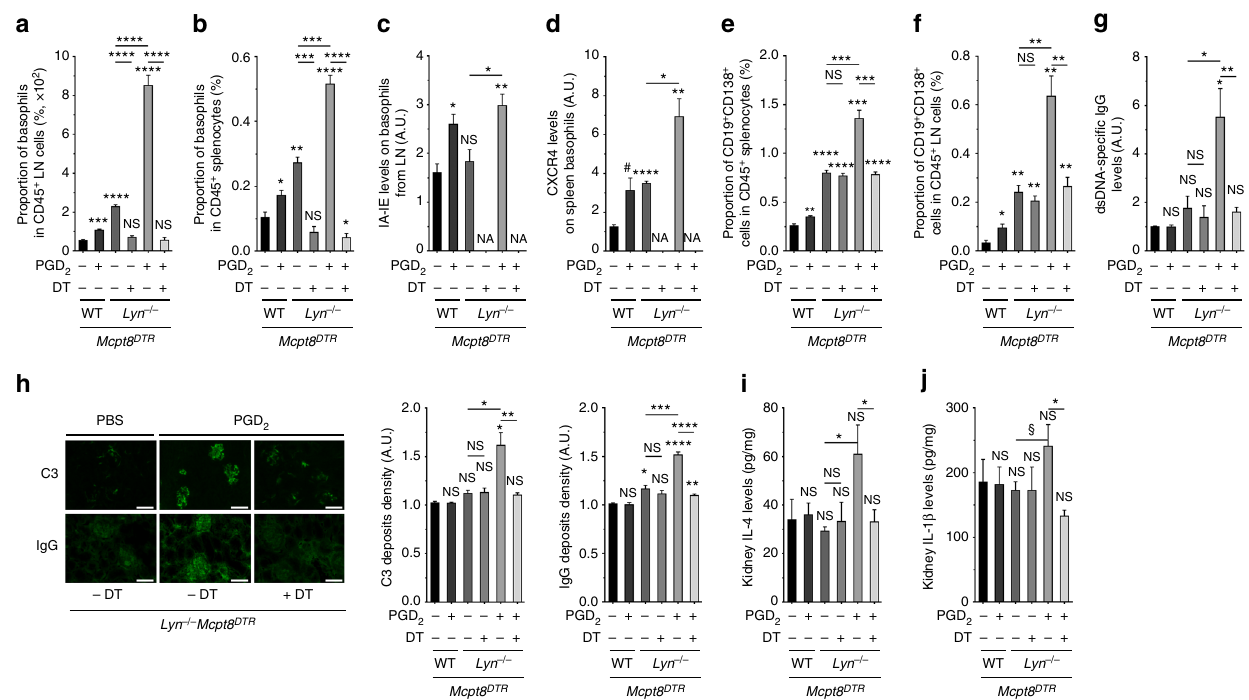
Fig. 5 PGD 2 injections induce basophil-dependent disease acceleration in young Lyn – / – mice. a , b Proportion of basophils among living CD45 + cells in lymph nodes (LN) ( a ) (cervical, brachial, and inguinal) and in spleen ( b ) from young Mcpt8 DTR (WT) or Lyn – / – Mcpt8 DTR ( Lyn – / – ) mice injected over 10 days with PBS or PGD 2 along or not with diphtheria toxin-mediated basophil depletion (DT) as described in the Methods. From left to right, n = 3/4/4/4/4/5. c , d IA-IE expression on LN basophils ( c ) and CXCR4 expression on spleen basophils ( d ) in mice as in ( a ). NA not applicable. e , f Proportion of CD19 + CD138